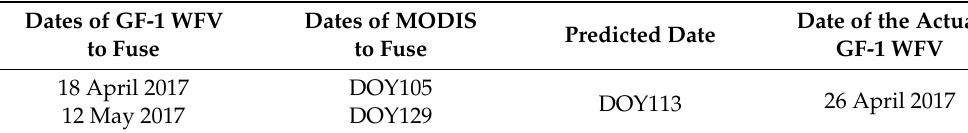
Table 5. The acquisition dates of GF-1 WFV and MODIS data.